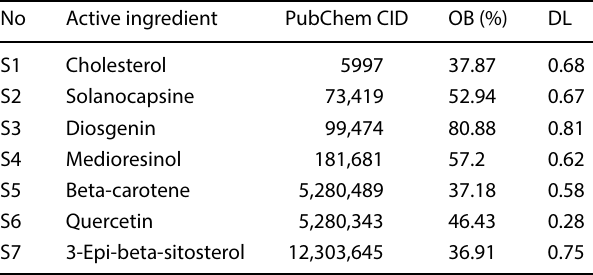
Table 1 Major active ingredients identified in S.